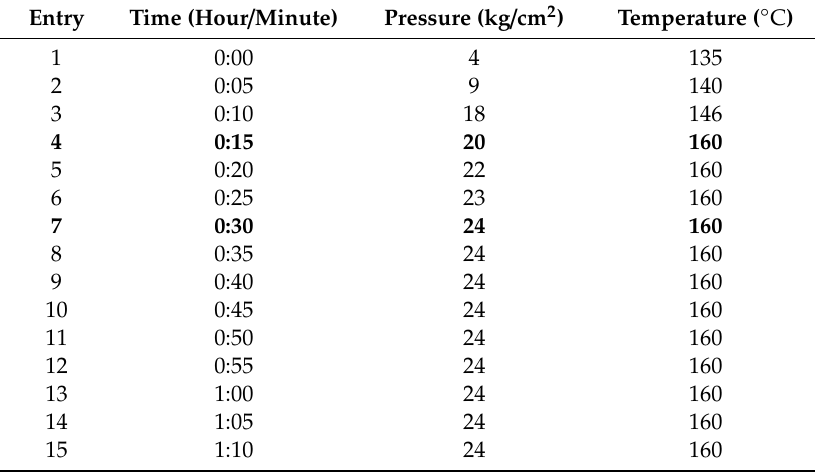
Table 2. Pressure over time for the catalytic transfer hydrogenation of nitrobenzene with formic acid.